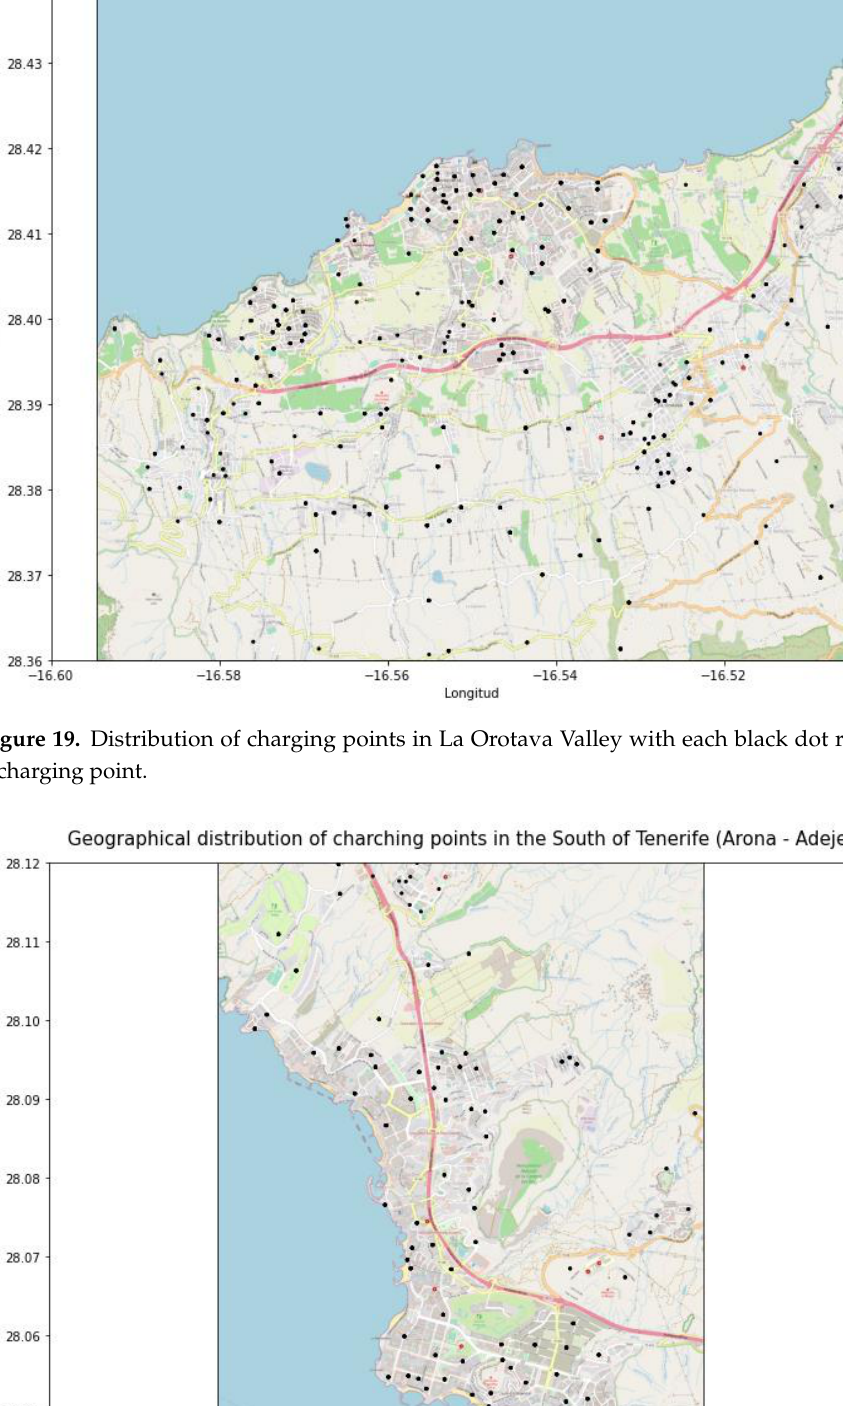
Figure 18. Distribution of charging points in the metropolitan area of Tenerife with each black dot representing a charging point.